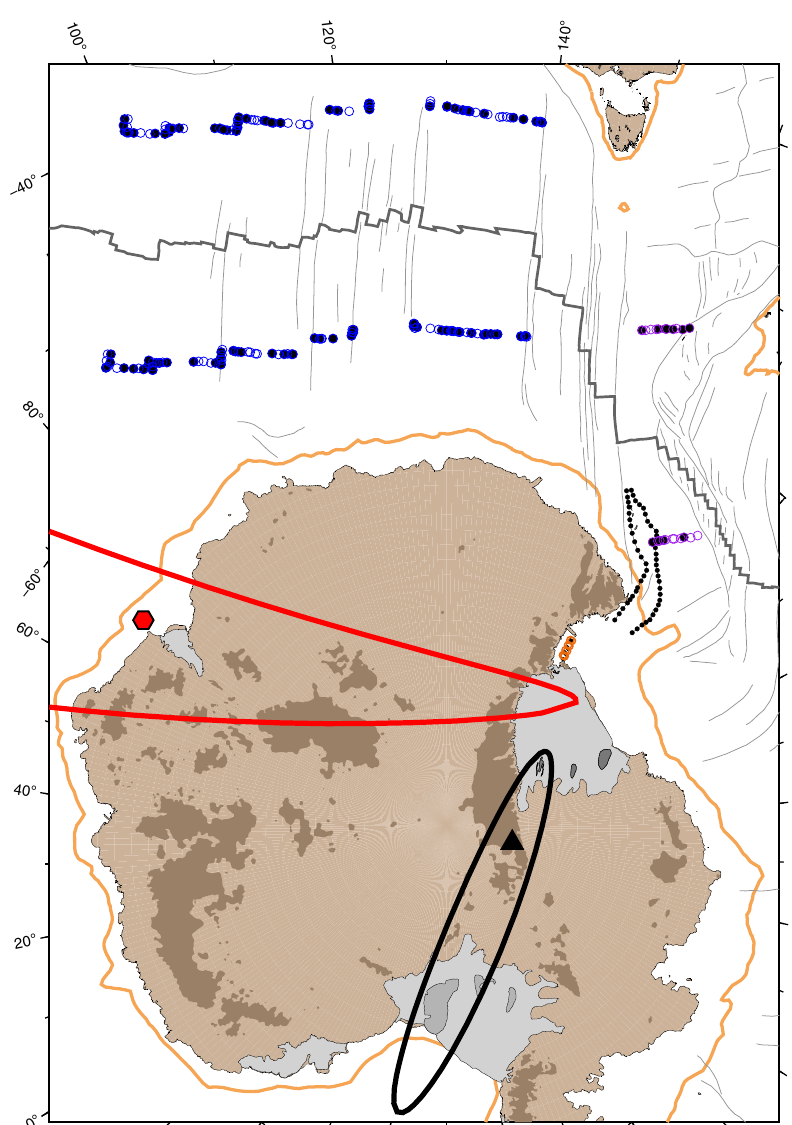
Fig. 4 Data locations used to constrain the Australia-East Antarctica-West Antarctica three-plate solution for anomaly 8o time. Blue circles mark Australia- East Antarctica picks, purple circles mark Australia-West Antarctica and orange circles show the boundaries of the Terror Rift (East-West Antarctica picks). Empty and fi lled symbols are the original and rotated picks, respectively. The resulting pole is shown by the red hexagon and the Eocene- Oligocene stage rotation pole for East-West Antarctic motion (anomalies 18o – 12o) 18 is shown by the black triangle. Ellipses delineate the 95% con fi dence boundaries for these poles. Orange lines delineate 1000m contours. Black dotted lines delineate the northern edge of the WARS (Fig.